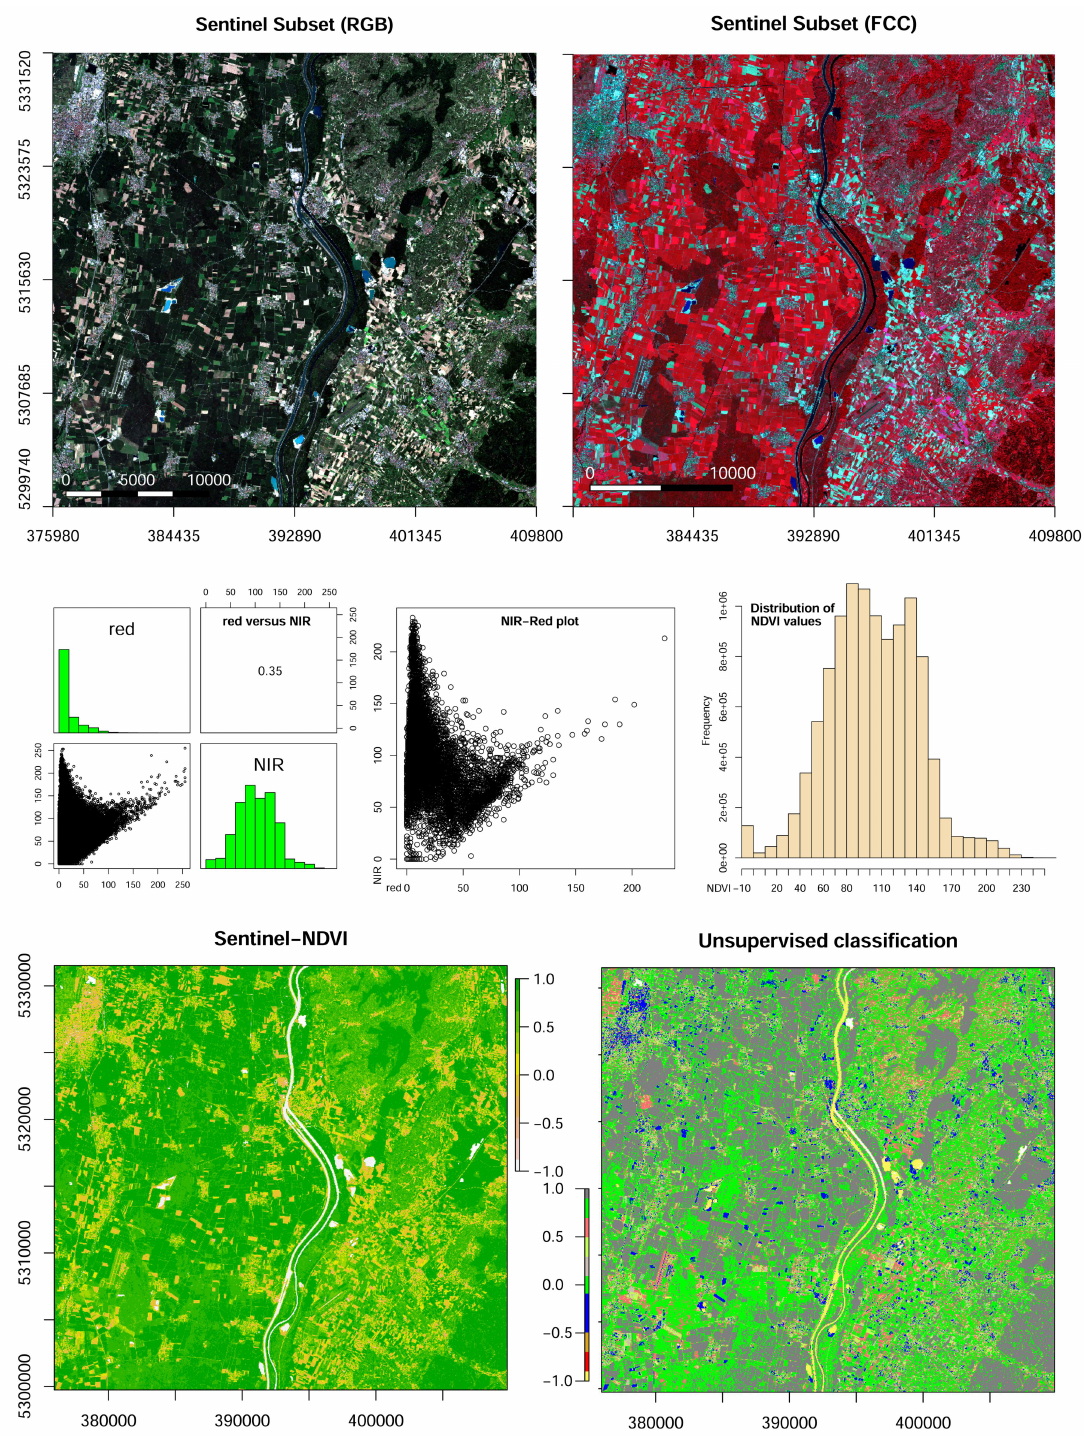
Figure 4. Vegetation-cover monitoring workflow for a Sentinel-2 hyperspectral satellite image (sensing date 18 August 2019), 10 m spatial resolution in R (ch4), G (ch3), B (ch2), NIR (ch8). RGB and FCC (false color composite) subsets were plotted from the original data. Reflection characteristics of the red (ch4) and the near infrared (NIR, ch8) bands were used to generate the Normalized Di ff erence Vegetation Index (NDVI). NDVI values were plotted against an unsupervised 10-class classification with 500 random iterations. Both plots visualize the strong di ff erences in land-use strategies, condition of the physical vegetation, and irrigation activity in the western (France) and eastern (Germany) part of the Upper Rhine Area.